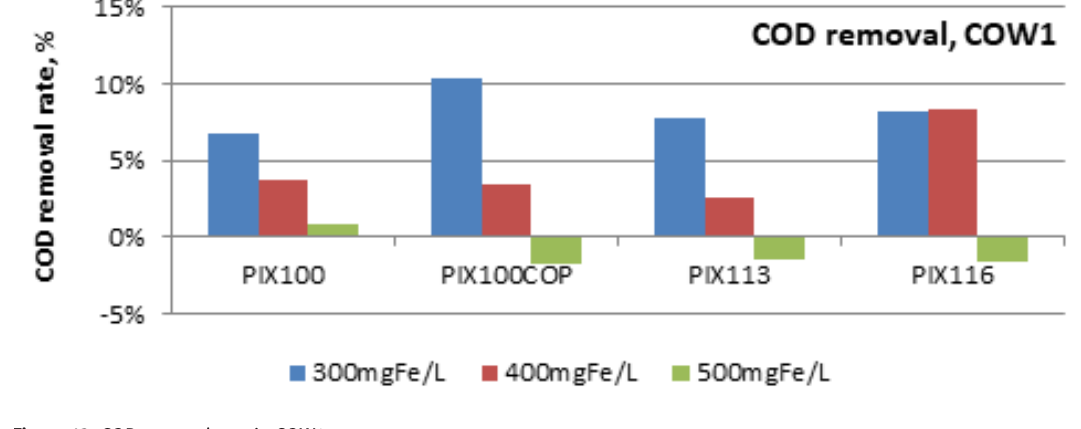
Figure 13: COD removal rate in COW1.